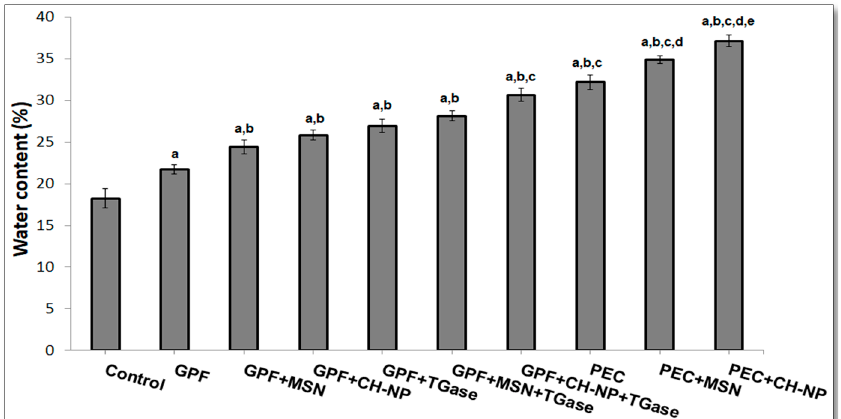
Figure 3. Effect of different hydrocolloid coatings on fried kobbah water content. “Control” represents the kobbah sample dipped in distilled water. Columns “a” indicate values significantly different from the control sample; columns “b” report values significantly different from grass pea flour (GPF)-coated kobbah; columns “c” indicate values significantly different from GPF + mesoporous silica nanoparticles (MSN)-coated kobbah or GPF + transglutaminase (TGase)-coated kobbah; columns “d” indicate values significantly different from pectin (PEC)-coated kobbah; columns “e” indicate values significantly different from PEC + MSN-coated kobbah. Additional details are reported in the main text.